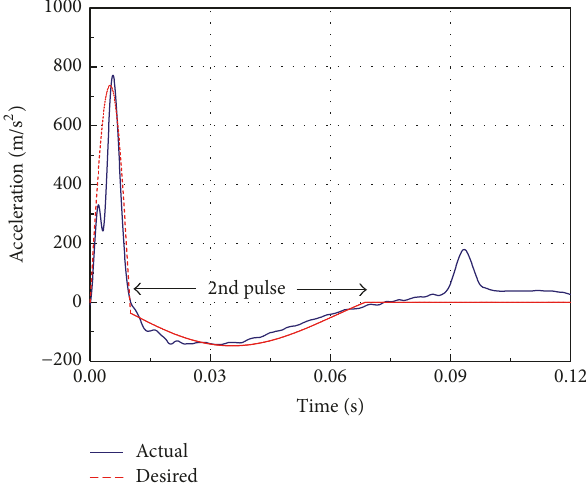
Figure 14: Comparison test and simulation results (Test #5: